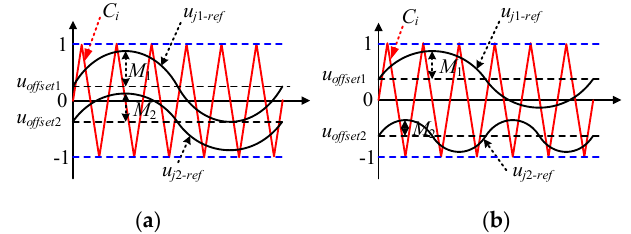
Figure 3. Modulating references under ( a ) CF mode and ( b ) DF mode.